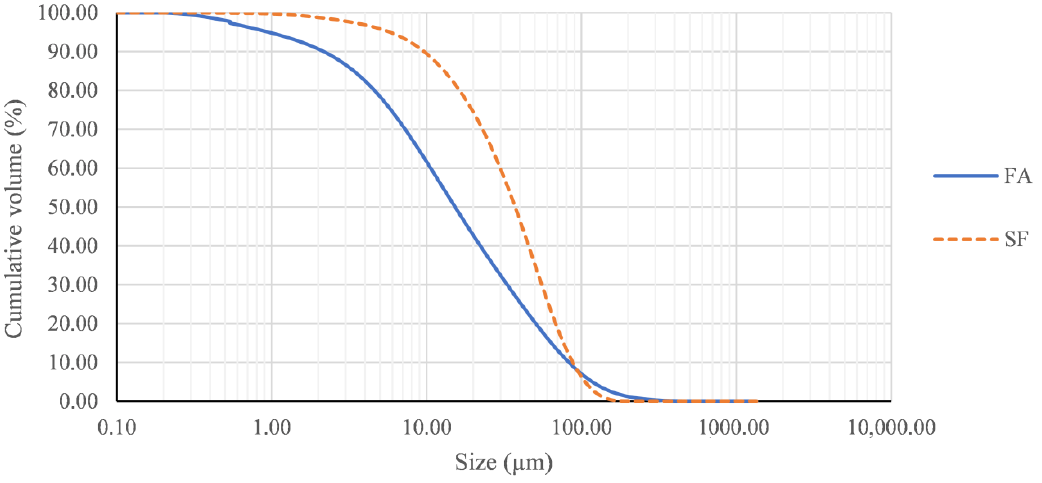
Figure 2. Particle size distribution of fly ash (FA) and silica fume (SF).